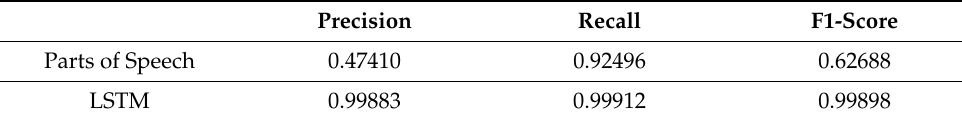
Table 3. Test results from combining the datasets and splitting train/test along